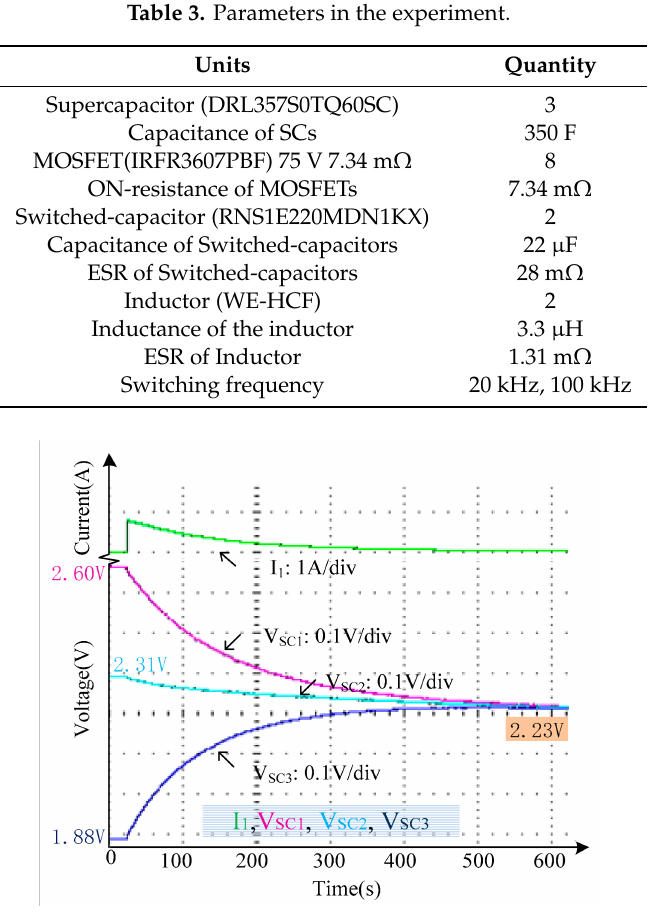
Figure 11. The ZCS mode balancing waveform from the experiment in the